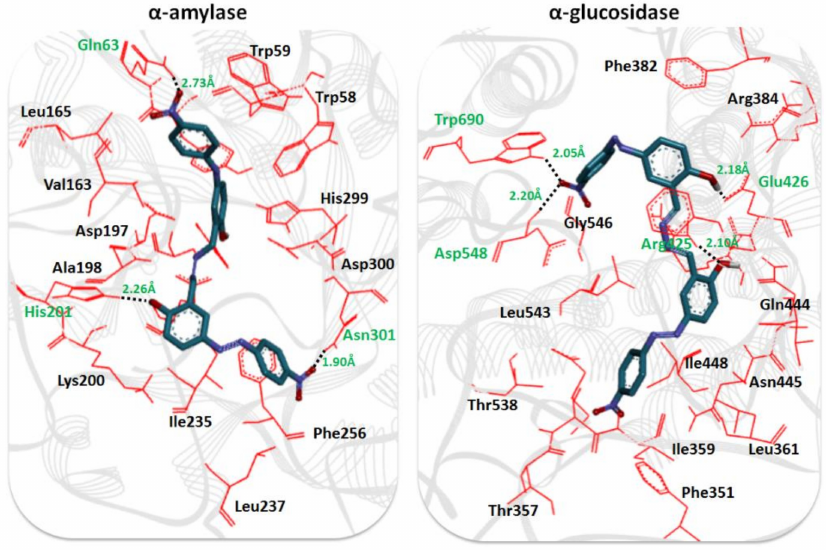
Figure 6. Docking of 5g with α -amylase and α